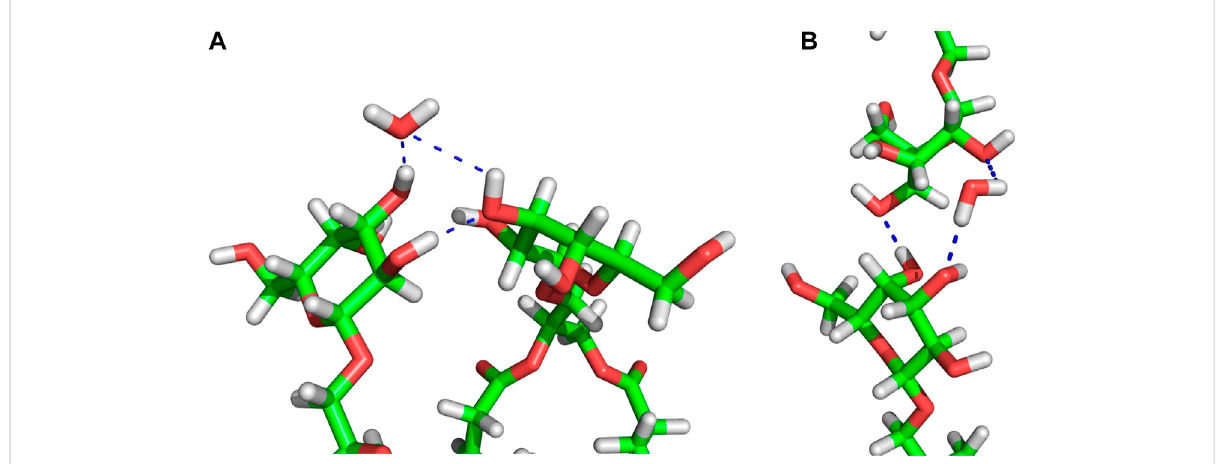
FIGURE 5 ExamplesofMGDG-MGDGH-bondsandwaterbridgesattheinterfaceoftheW15connect-15region. (A) Horizontal(betweenlipidsbelonging to the same bilayer lea fl et) interactions; (B) vertical (between lipids belonging to the apposing lea fl ets) interactions. The molecules are shown as sticks in standard colours (acyl chains are cut off). The dotted blue lines represent intermolecular interactions. In (A) the water molecule is an acceptor of two H-bonds, in (B) the water molecule is a donor of two